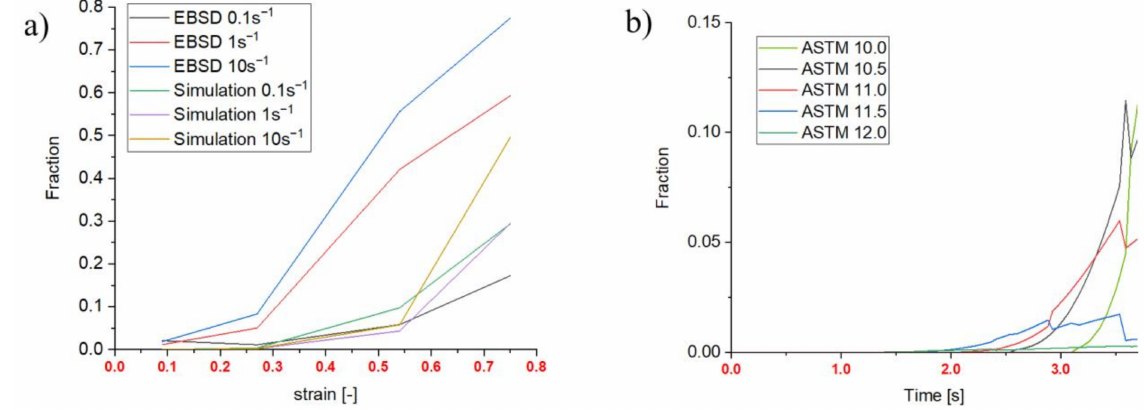
Figure 11. Dynamic recrystallization of microstructure A: ( a ) Recrystallized fractions over strain (980 ◦ C); ( b ) DRX classes 980 ◦ C, 0.1 s − 1 , strain: 0.54.